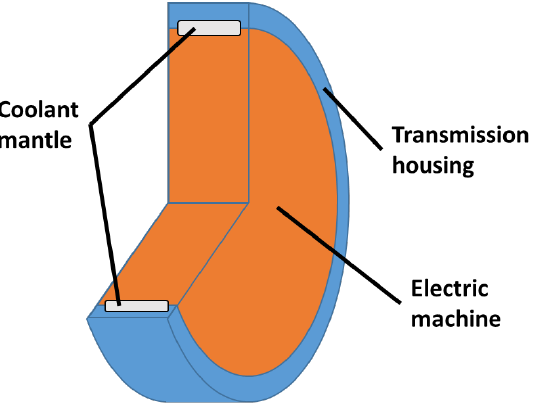
Figure 1. Visualization of the experimental setup: electric machine inside the transmission housing, including the coolant mantle [19].